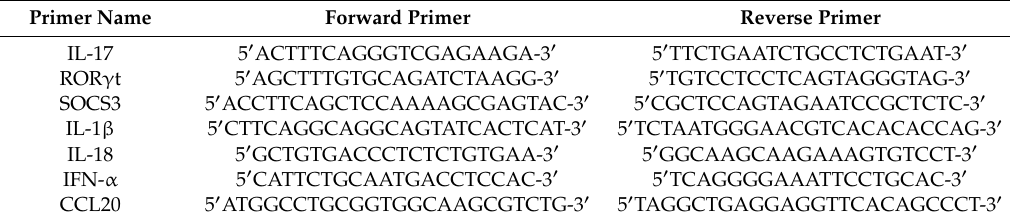
Table 1. Primers used for real-time polymerase chain